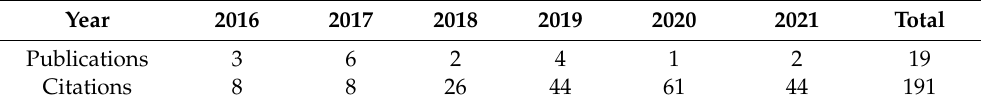
Table 6. Publication and citation counts based on the analysis pattern: TS = ((nuclear power) AND energy security educ*). Source: Web of Science